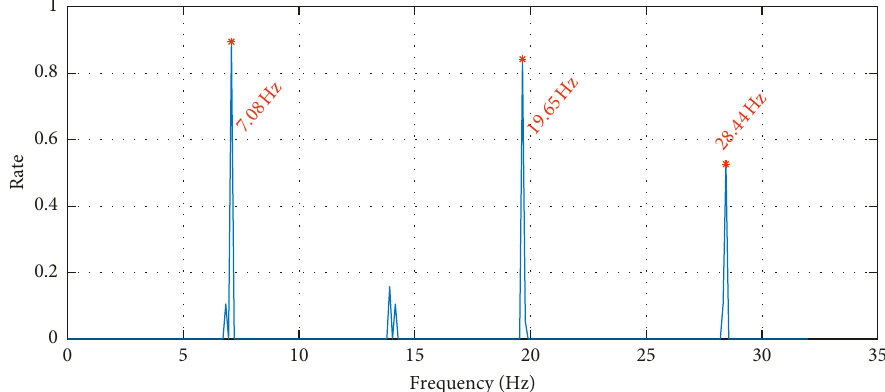
Figure 7: Example of selecting modes by the rate of stable points over orders (CoS-SSI, SNR